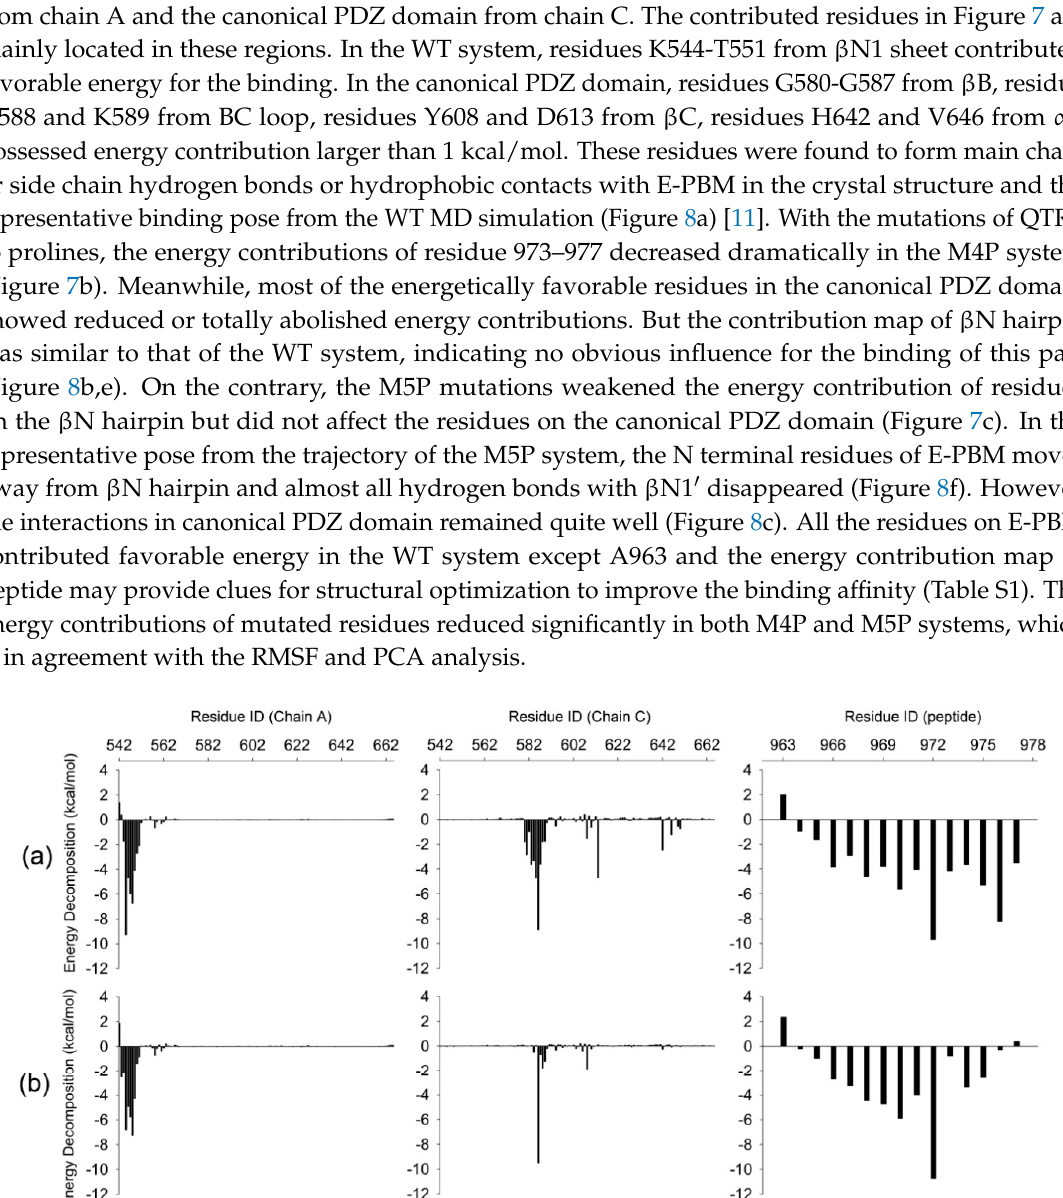
Table 1. Comparison of binding energy components between Shank3 N-PDZ and SAPAP E-PBM in three complex systems.